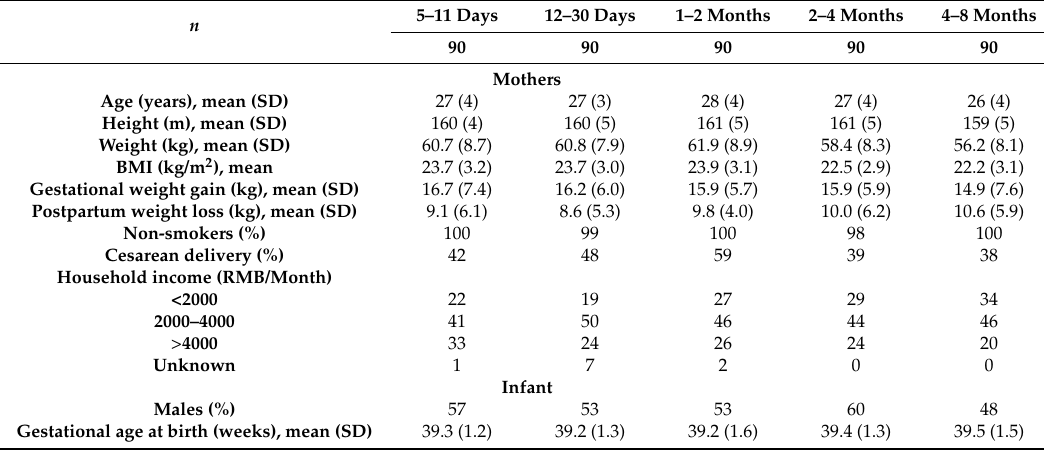
Table 1. Study population